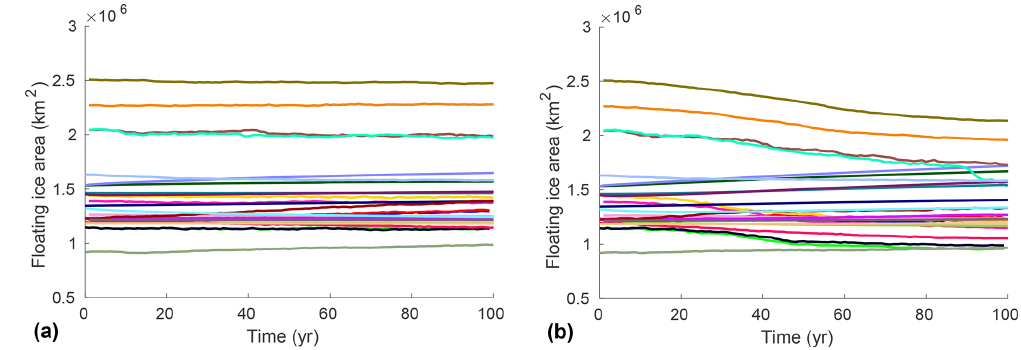
Figure 11. Evolution of Antarctic ice shelf extent for the (a) ctrl and (b) abmb experiments.